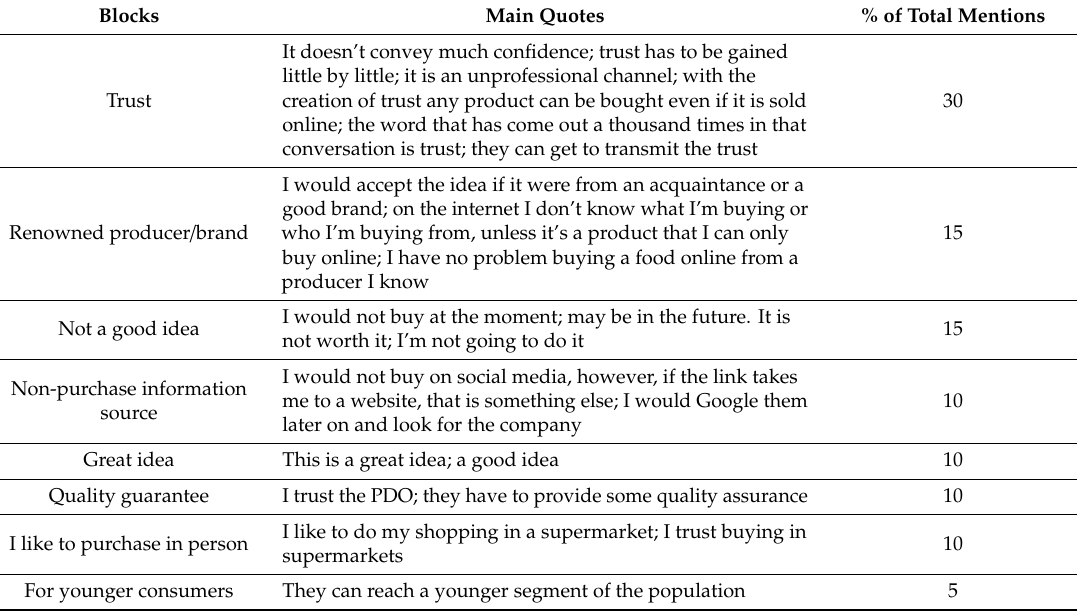
Table 3. Consumers’ comments on the use of social media-based